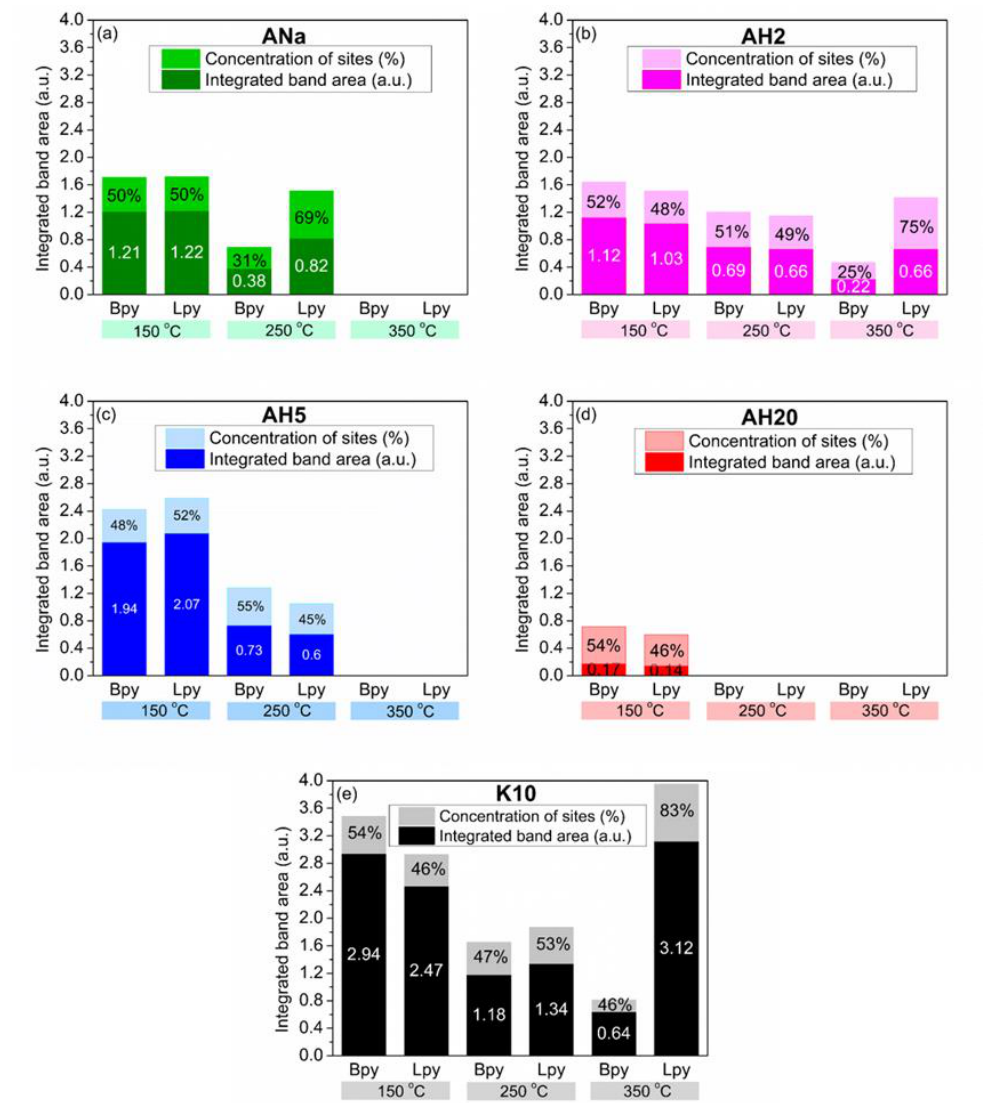
Figure 9. Calculated ratios for Bpy and Lpy acidic sites after pyridine adsorption at 150 °C and desorption at 250 and 350 °C: ( a ) ANa; ( b ) AH2; ( c ) AH5; ( d ) AH20; ( e ) K10.